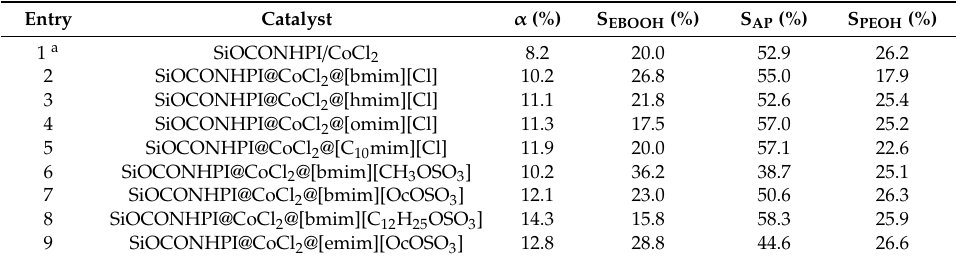
Table 2. Influence of the ionic liquid structure on catalytic activity of SiOCONHPI@CoCl 2